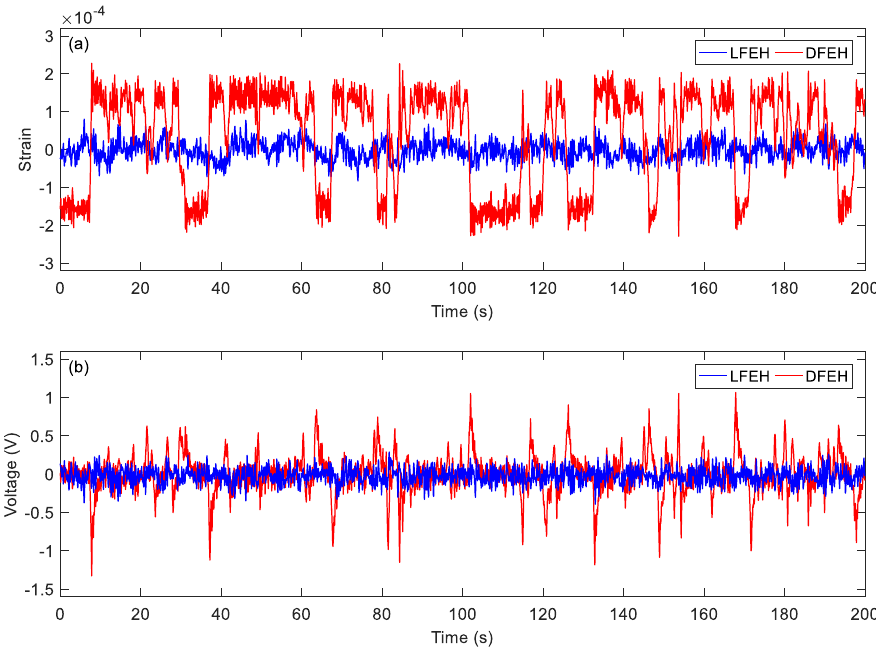
Figure 10. ( a ) Time histories of strain response, ( b ) time histories of voltage response ( c ) spectrum of strain ( v = 2.5 m/s).